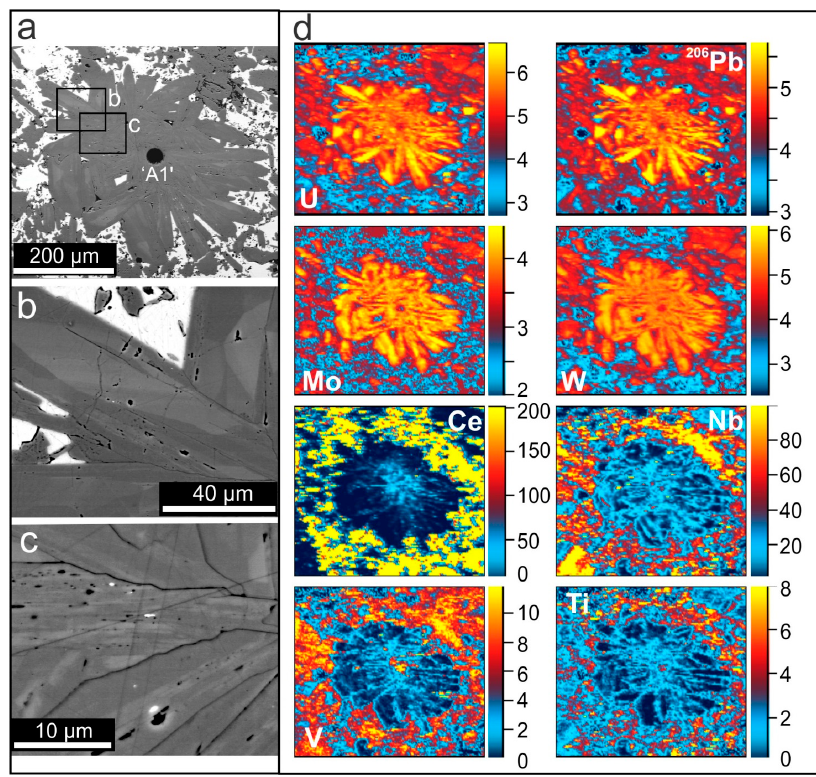
Figure 5. BSE images ( a )–( c ) showing textural details of a radial aggregate of hematite hosted in bornite (white in (a,b)) from Olympic Dam. Note the zoning and porosity within individual lamellae depicted on the BSE images in (b) and (c), respectively. ( d ) LA-ICP-MS element maps of the hematite aggregate shown in (a); note good correspondence between textures on BSE images and specific groups of elements, i.e., zoning with respect of U, Pb, Mo and W (middle parts of lamellae), and enrichment in HFSE in the porous, marginal parts of the same lamellae. Scales in counts-per-second ( × 10 3 except for Ce and Nb). Measured isotopes: 238 U, 206 Pb, 95 Mo, 182 W, 140 Ce, 93 Nb, 51 V, 47 Ti. Controls on the diversity of trace element signatures derive from different fluid sources,